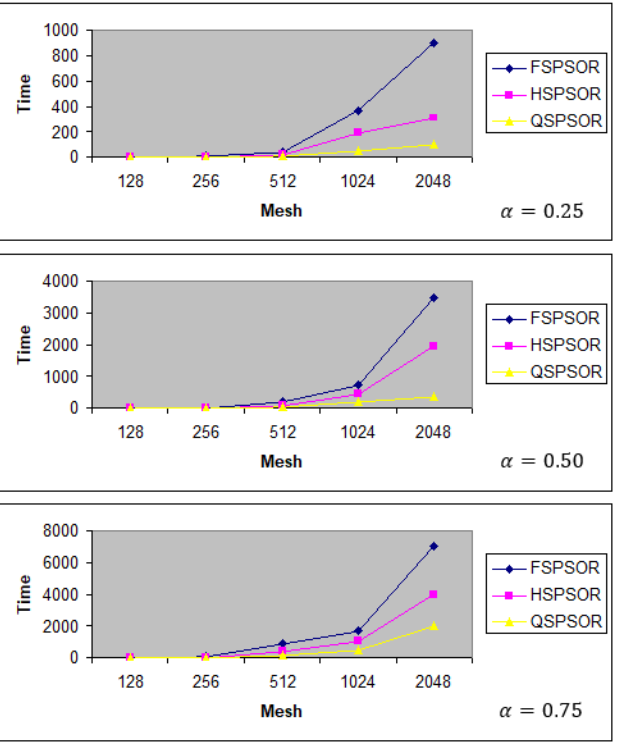
Figure 2. Graphs of performance of FSPSOR, HSPSOR, and QSPSOR methods to solve Example 1, showing mesh sizes versus execution time for three different fractional orders.